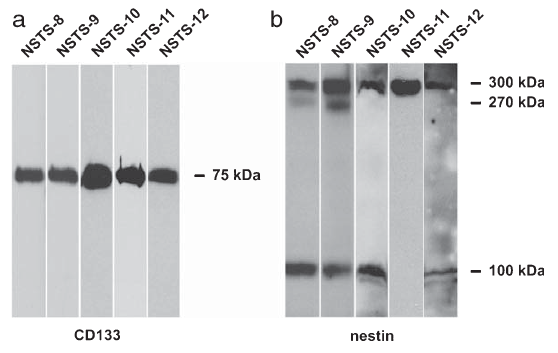
Fig. 4. Immunoblot analysis of the CD133 and nestin expression in rhabdomyosarcoma cell lines. Analysis of the CD133 expression in all five rhabdomyosarcoma cell lines (a). Analysis of the nestin expression in all five rhabdomyosarcoma cell lines